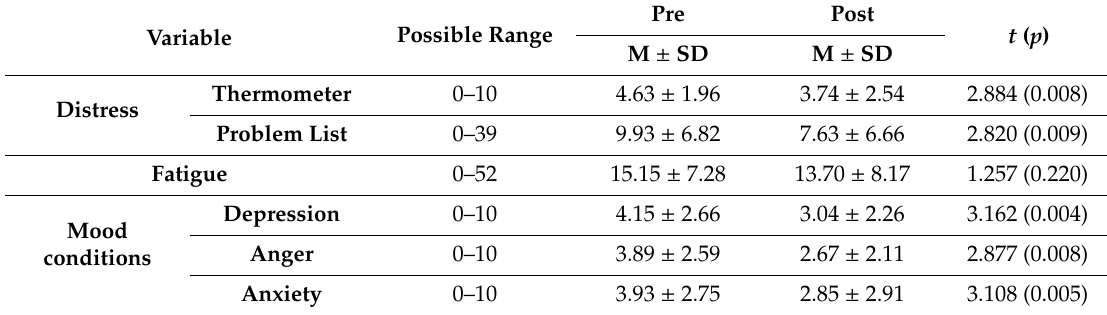
Table 3. Comparison of emotional variables (N = 27).